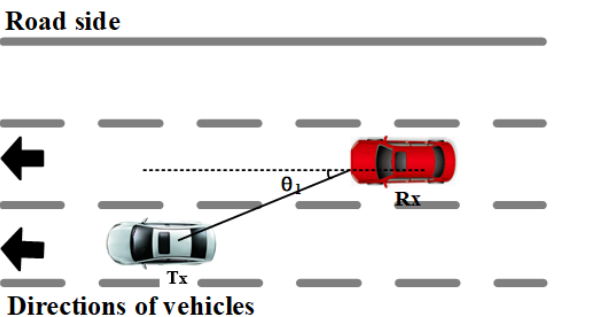
Figure 6. Schematic diagram of the relative speed of two cars traveling in the same